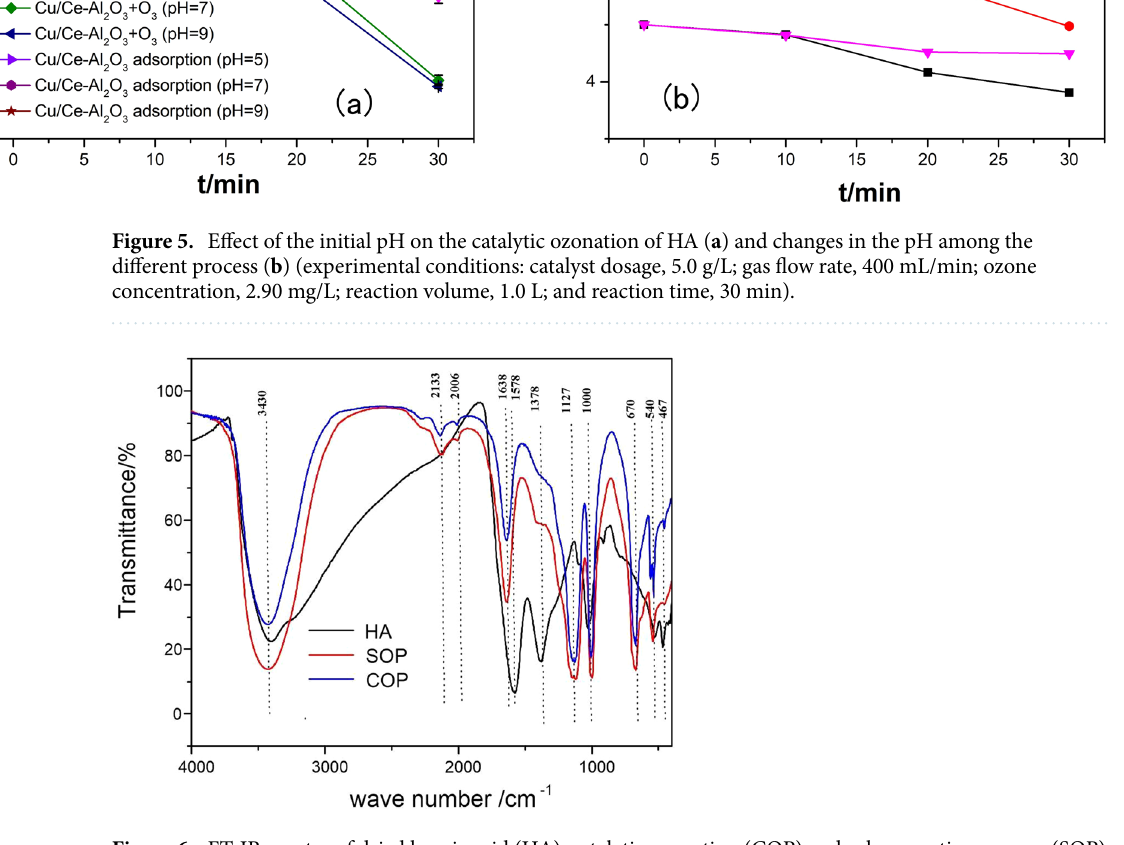
Figure 6. FT-IR spectra of dried humic acid (HA), catalytic ozonation (COP) and sole ozonation process (SOP)